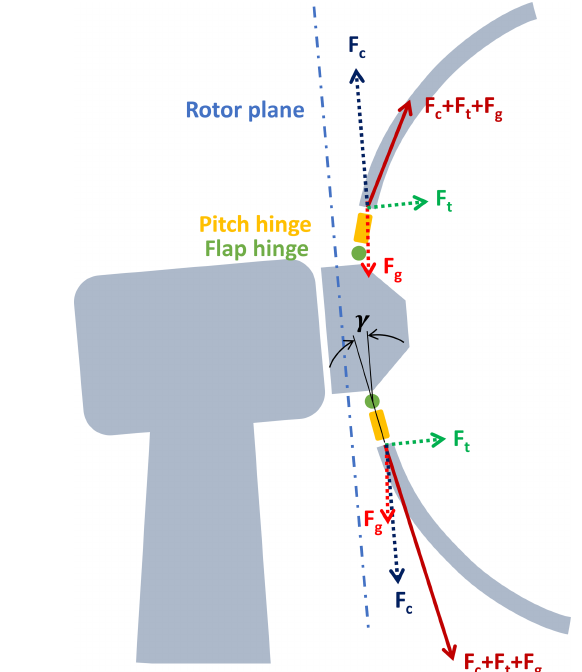
Figure 1. Schematic view of the active load-alignment